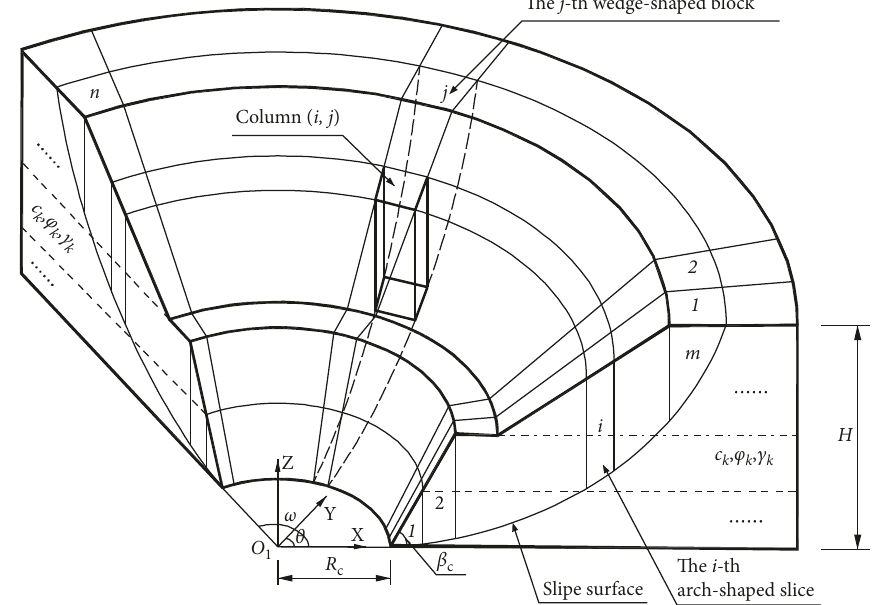
Figure 1: Typical geometry of an axisymmetric concave slope (1/4 model shown).